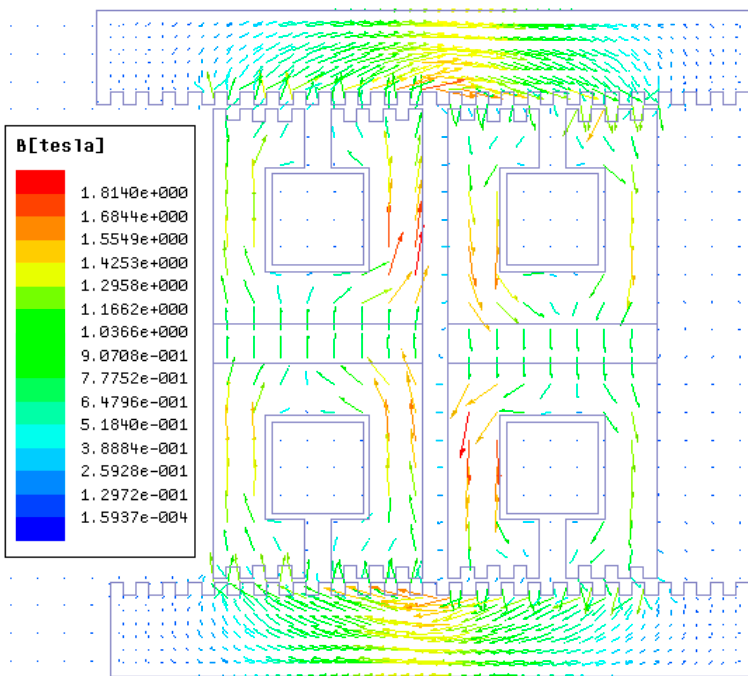
Figure 10. Flux distribution of the machine.